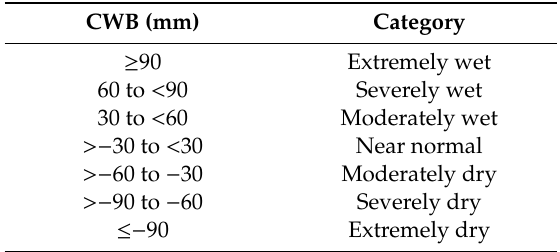
Table 3. Classification of meteorological drought designed for climatic water balance (CWB) of a single month.